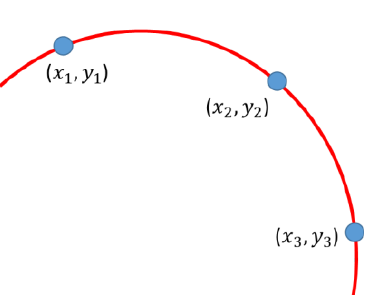
Figure 3. Curvature defined by three coordinate points.